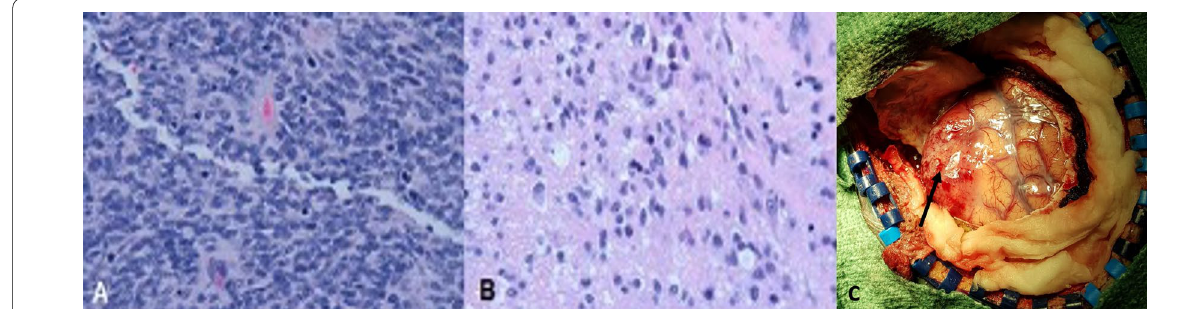
Fig. 3 A HE 40 embryonic undifferentiated component, blue cell, densely cellular, pseudo-red shaper. B HE × moderate atypia. C Intraoperative image visualizing embryonic component of the first surgery